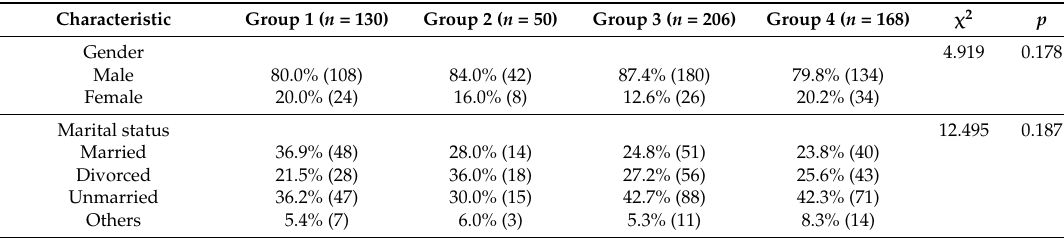
Table 1. Participant characteristics (1) % ( n